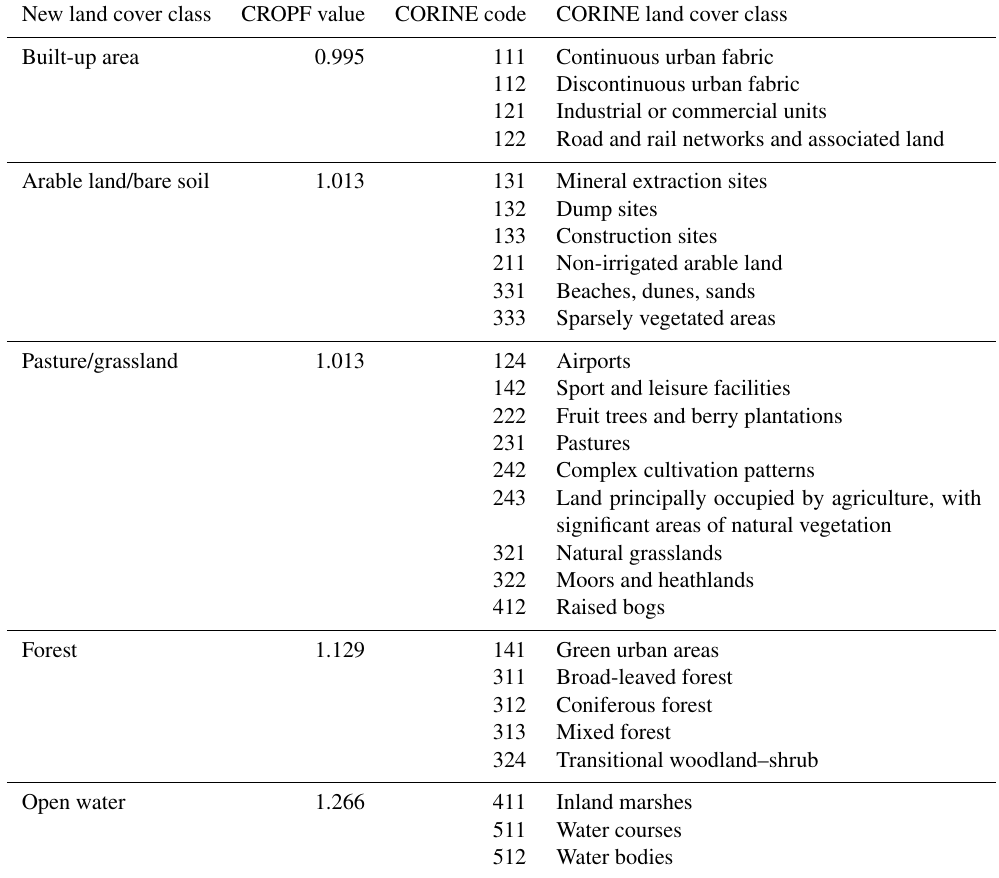
Table A2. Reclassification of the CORINE land cover classes used in the hydrological simulations and land cover coefficient values (CROPF) for the simplified land cover classes, used in the evapotranspiration